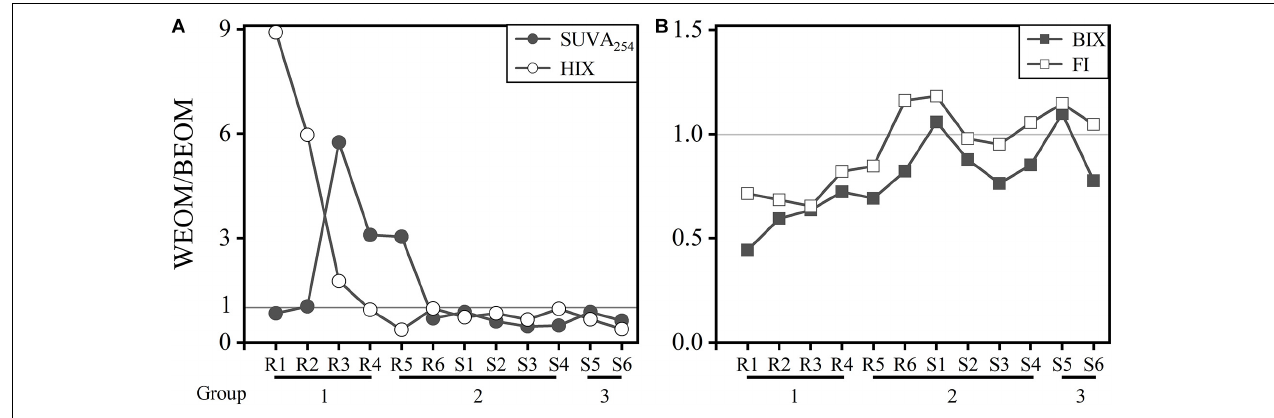
FIGURE 6 | Optical indicator ratio [specific UV absorbance at 254 nm (SUVA 254 ), humification index (HIX), fluorescence index (FI), and biological index (BIX)] between the water-extractable organic matter (WEOM) (A) and base-extractable organic matter (BEOM) (B) .